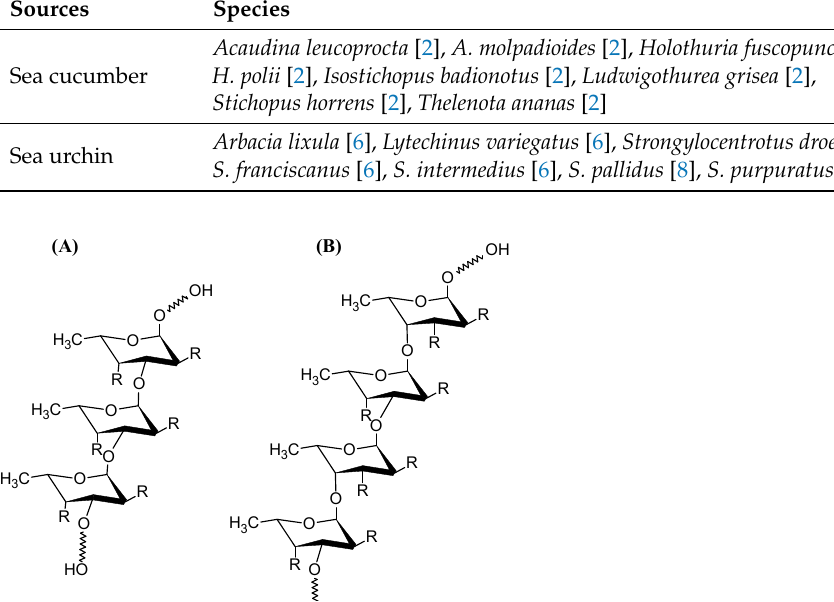
Figure 1. The chemical structure of fucoidan. ( A ) backbone of α‐ (1 → 3) ‐ L ‐ fucopyranose residues; ( B ) backbone alternating α‐ (1 → 3) ‐ linked and α‐ (1 → 4) ‐ linked L ‐ fucopyranose residues. R = OH or OSO 3 − . Table 1. Sources of fucoidan derived from brown algae, sea cucumber, and sea urchin species. Sources